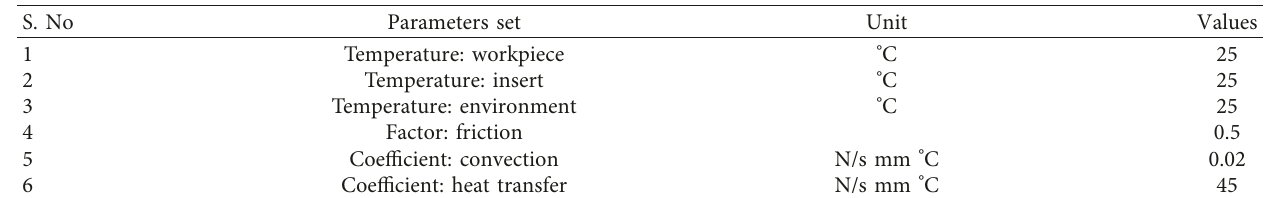
Figure 1: (a, b) Meshed WC tool and 35NCD16 work piece. Table 2: Simulation